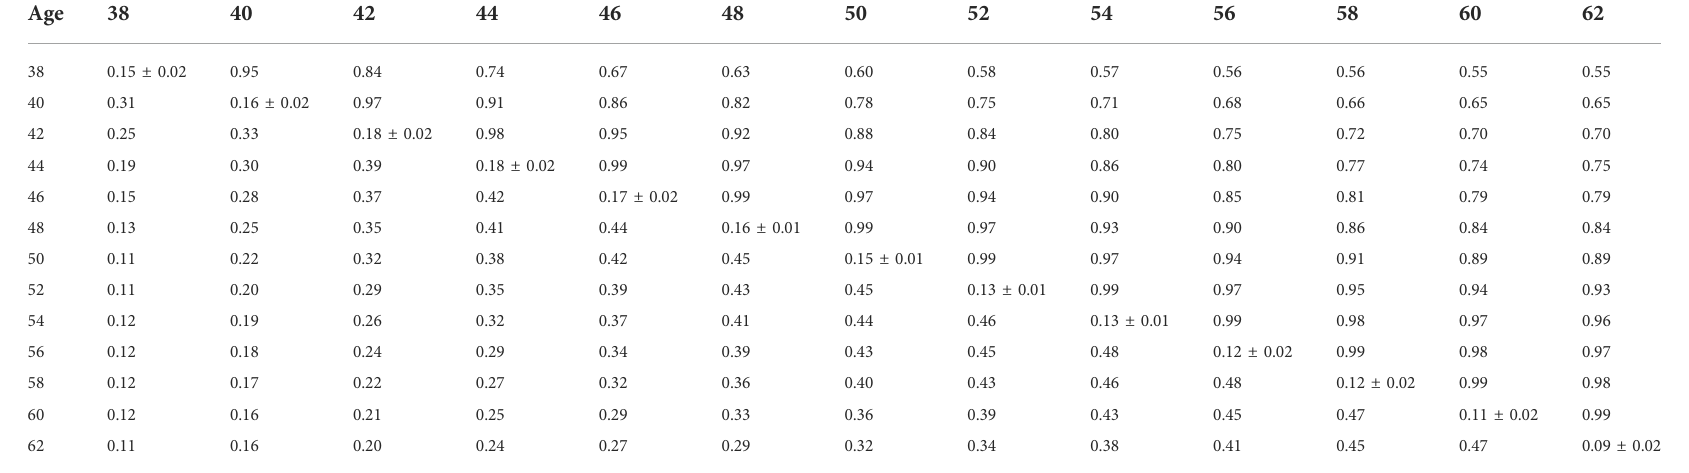
TABLE 9 Estimates of heritability (diagonal), phenotypic correlations (below diagonal), and genetic correlations (above diagonal) for hatch of set (HOS) using the pedigree random regression model. Age